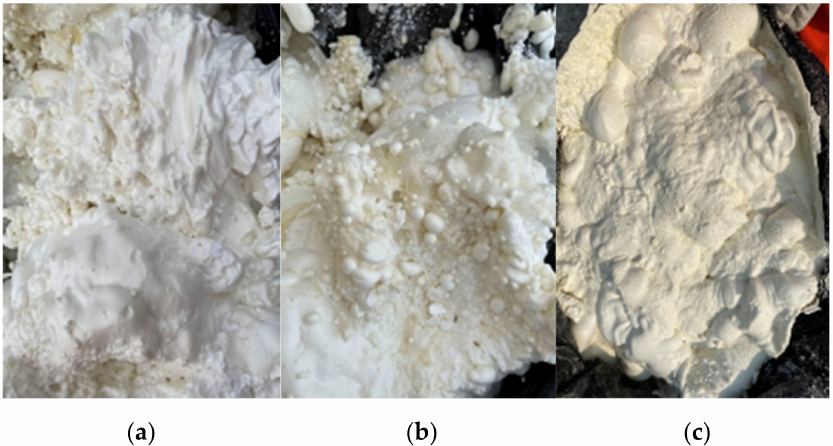
Figure 4. Illustrations of polymer foam at different λ of Components A and B: ( a ) λ > 1, ( b ) λ < 1, ( c ) λ =